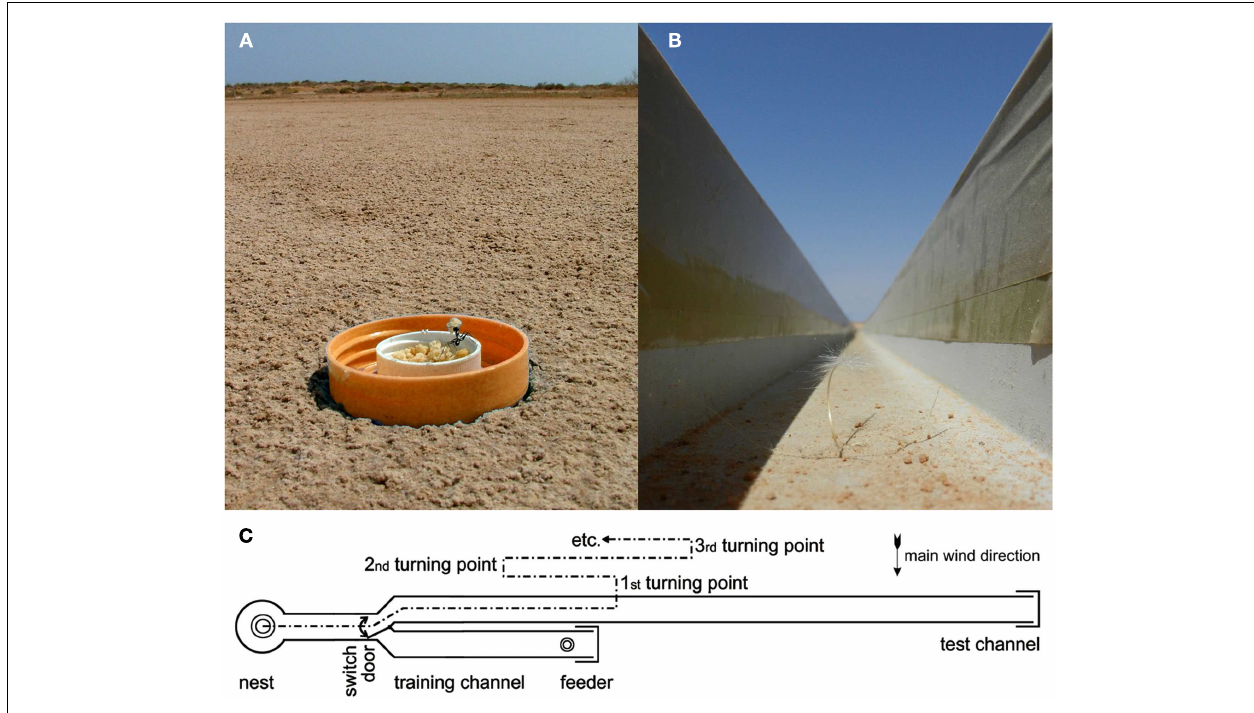
foragers but dropped during sampling of different items. (B) View along a training channel (width 7cm, walls 7cm high) from the nest entrance. Tape covers on the walls provide a slippery surface that dissuades most ants from escaping from the channel, thus increasing the number of animals that find the feeder. (C) Arrangement of training (bottom) and test (top) channels and their connection to the nest via aY-junction with a switch